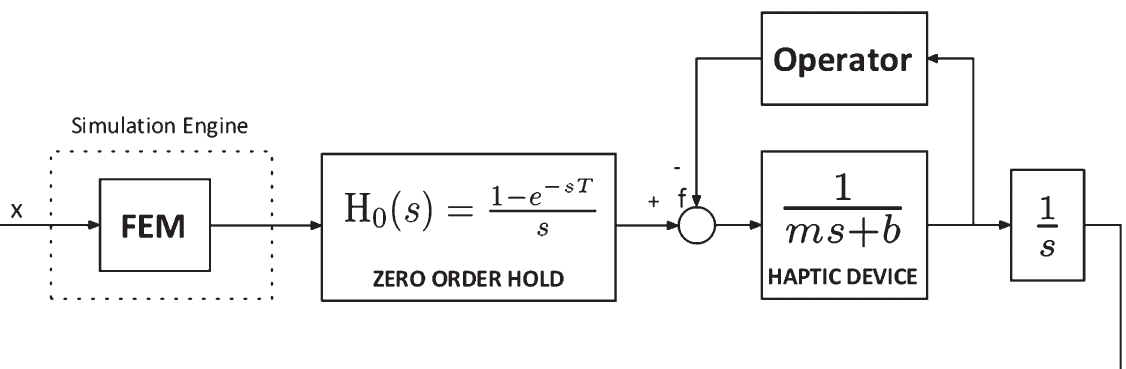
Fig. 8. System’s scheme. The simulation engine integrates the solver for the finite element model (FEM). The interaction between the operator and the haptic device is modeled. Finally the link between the simulation engine discrete time domain and the real continuous time domain is modeled with a zero order